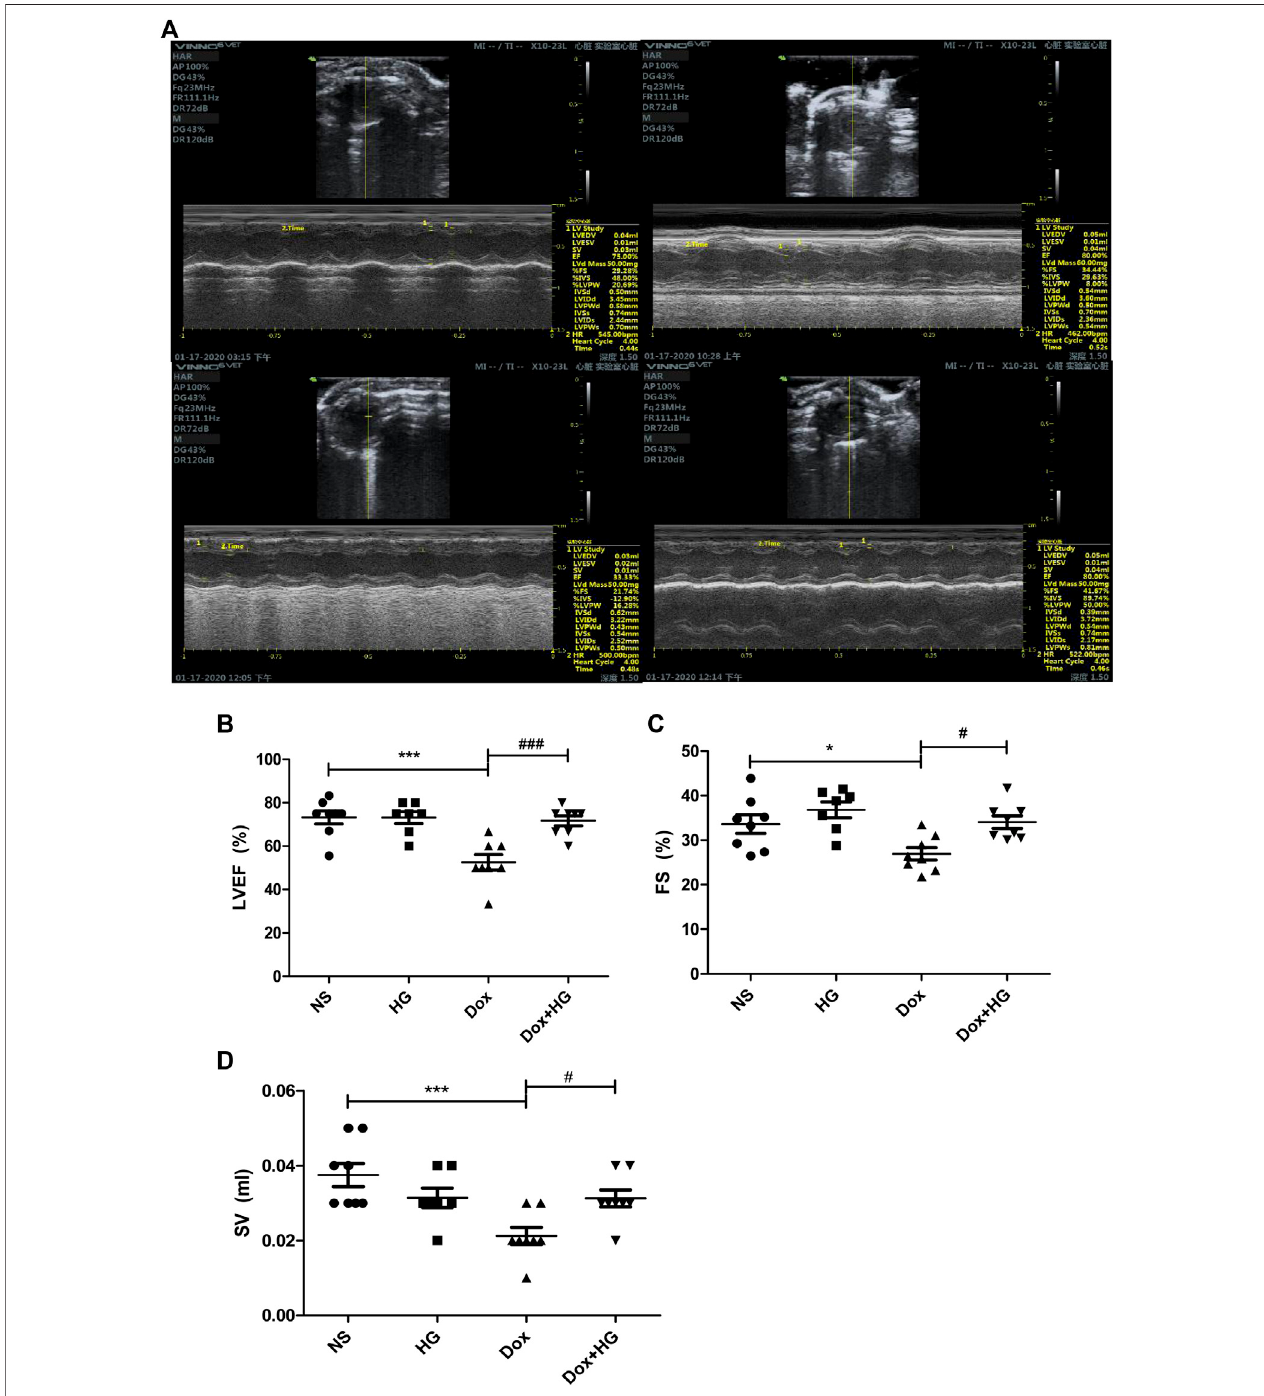
FIGURE 3 | HG improved DOX-induced cardiac dysfunction in vivo. (A) Representative M-mode echocardiographic images of mice in each group at 4 weeks. (B – D) Summaryof (B) ejectionfraction(EF), (C) shorteningfraction(FS),and (D) strokevolume(SV)dataineachgroup.Allvaluesarepresentedasmean±SEM;statisticalanalysiswas performed using Prism8.0 one-way ANOVA.* p < 0.05DOXvs NS; # p < 0.05DOX+ HG vs DOX. Animalnumbers: NS,n = 8;HG,n = 7;DOX, n = 10; DOX+ HG, n = 10.